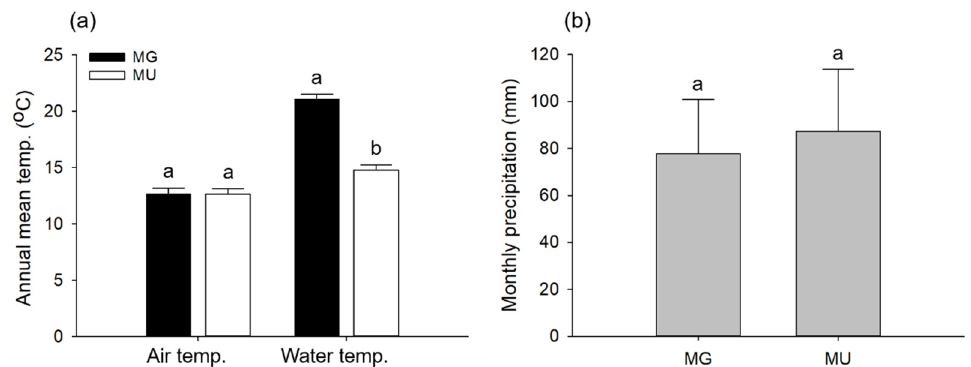
Figure 3. Comparison of annual mean temperature ( a ) and monthly precipitation ( b ) in the two study areas during the overlapping study period (MG: from August 2006 to July 2007, and MU: from August 2019 to July 2020). Bars represent standard error of the mean. Different letters indicate statistically significant differences ( t -test, p < 0.05).